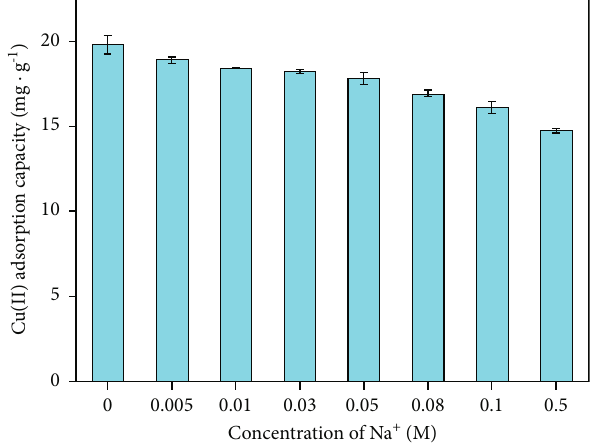
Figure 8: E ff ect of ionic strength on the adsorption capacity of SP- SBC for